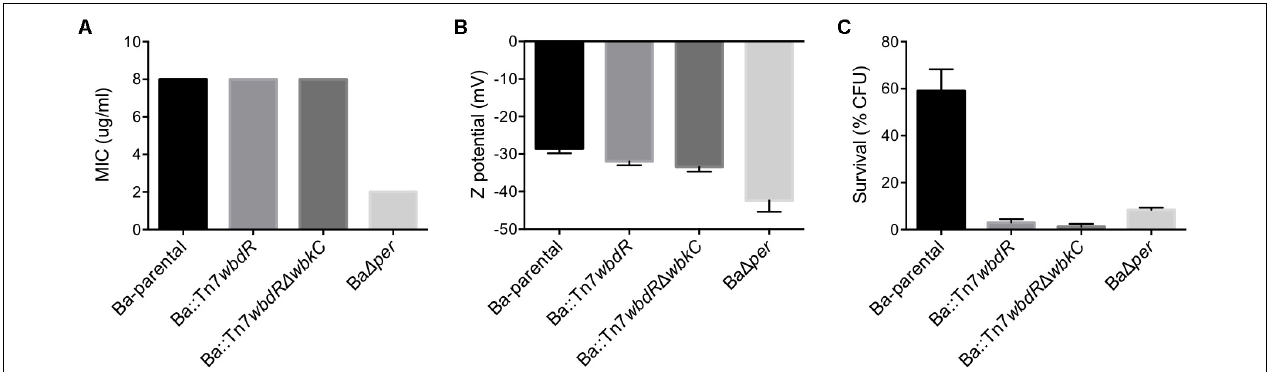
FIGURE 6 | Brucella abortus wbdR constructs display increased sensitivity to normal serum but not to bactericidal polycations. Polymyxin B sensitivity (representative results of three independent experiments) (A) , surface charge (Z potential) (mean of ± SD of three independent experiments) (B) and survival after 90 min of incubation in normal bovine serum (media ± standard error of three technical replicates representative of three independent experiments) (C) of Ba-parental, Ba::Tn7 wbdR , Ba::Tn7 wbdR (cid:49) wbkC and the R mutant Ba (cid:49) per.